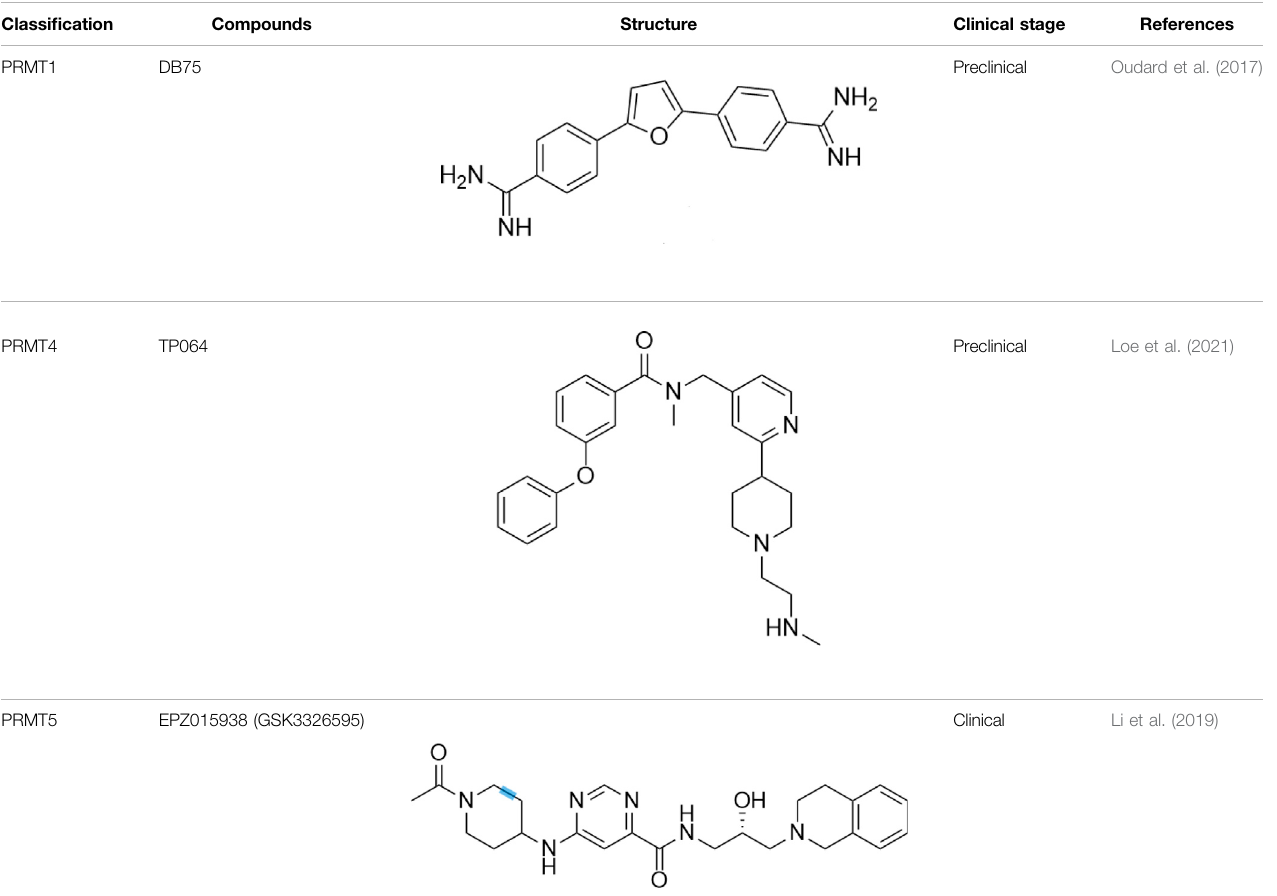
TABLE 3 | A list of histone arginine methyltransferase inhibitors under different phases of clinical trial and their indication. Histone arginine methyltransferase